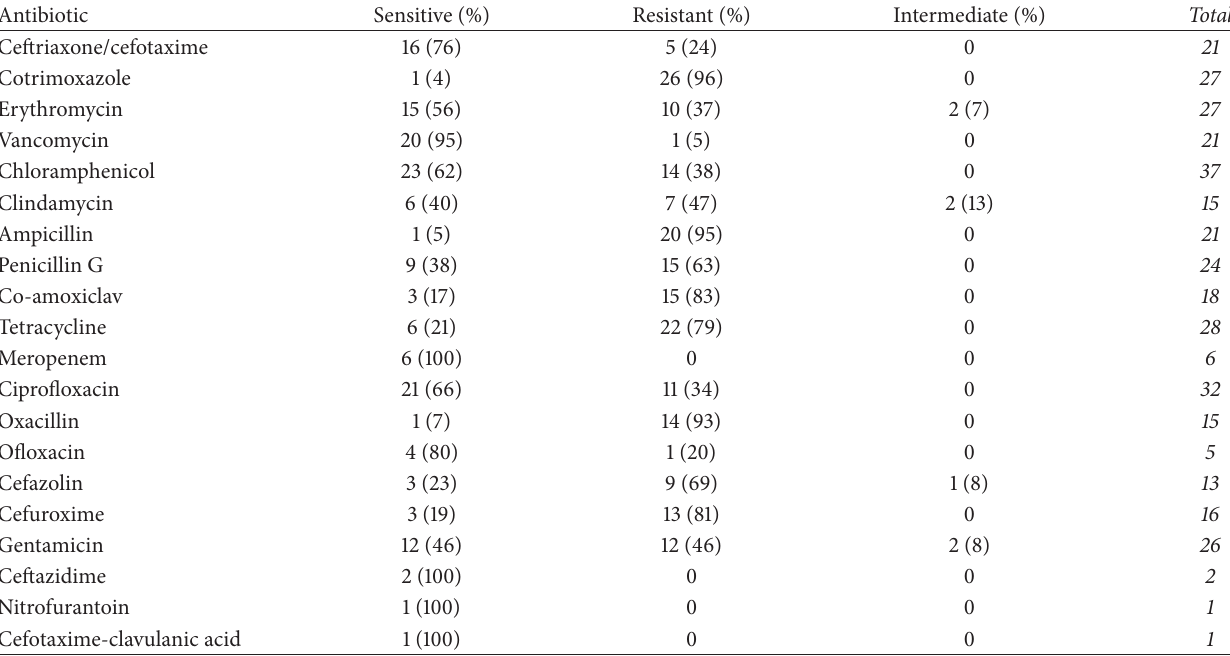
Table 3: Antibiotic sensitivity profile of positive cervicovaginal